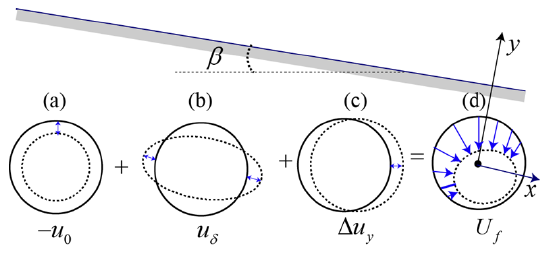
Figure 2. Basic displacement of the tunnel wall.